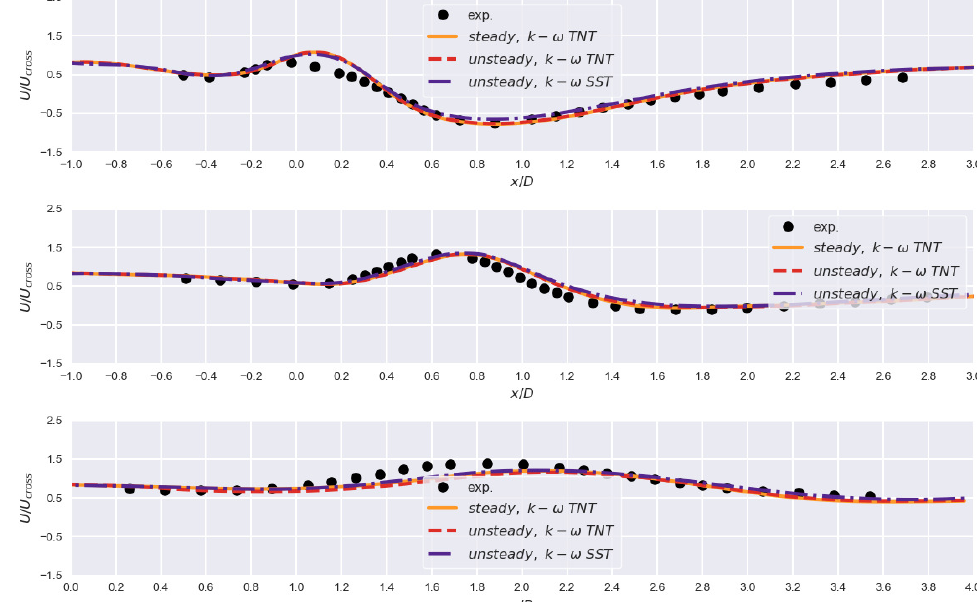
Figure 4. Velocity component U / U cross at z / D = 1.5, z / D = 3, z / D = 4.5 (top to bottom) for y / D = 0.